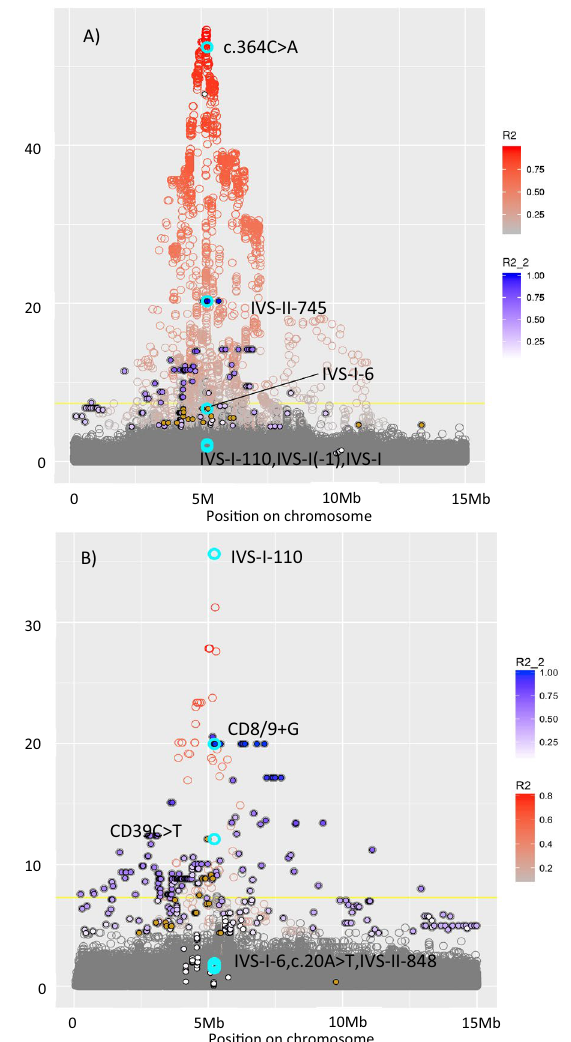
Figure 1. Regional association plot for variants located between 0 and 15 Mb on chromosome 11. Each circle represents a genetic variant. They are arranged on the x-axis by their location. The y-axis shows the p-value for their association with red cell distribution width in ( A ) Pomak and ( B ) MANOLIS. Pathogenic HBB mutations are highlighted in turquoise and labelled. The colouring of the circle (R2) indicates the strength of linkage disequilibrium (LD) with the most strongly associated HBB mutation, c.364C>A in MANOLIS and IVS-I-110 in Pomak. The blue filling of points (R2_2) indicates the strength of LD with the second most strongly